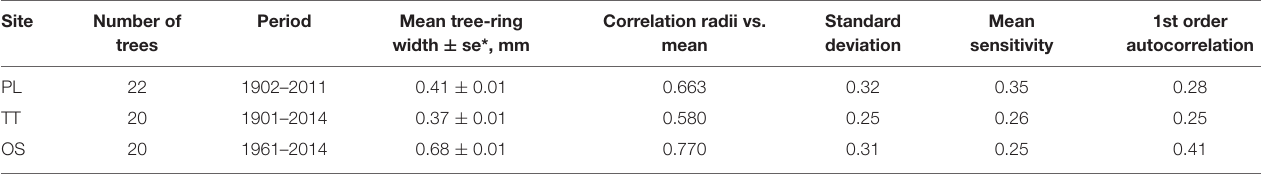
TABLE 4 | Statistical parameters of tree-ring width